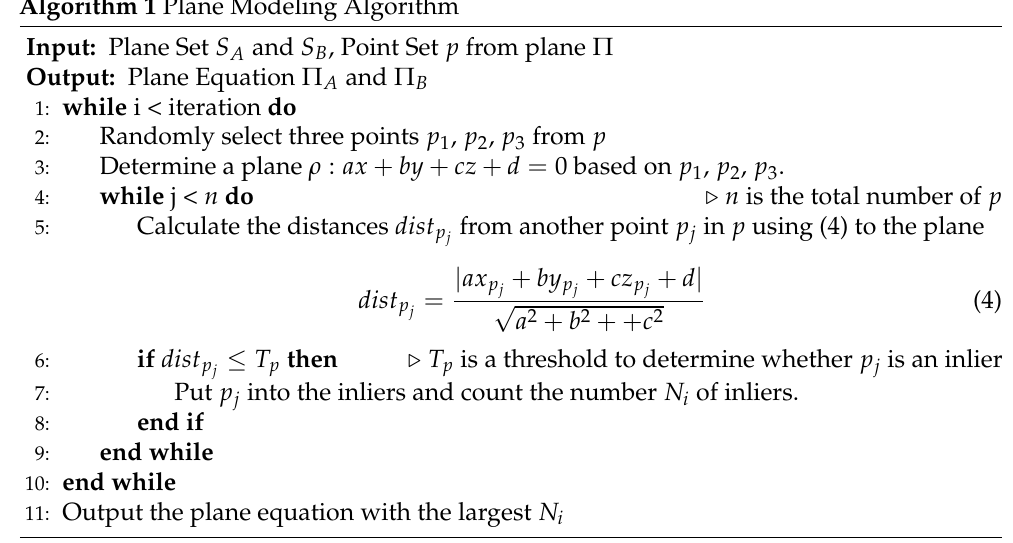
Algorithm 1 Plane Modeling